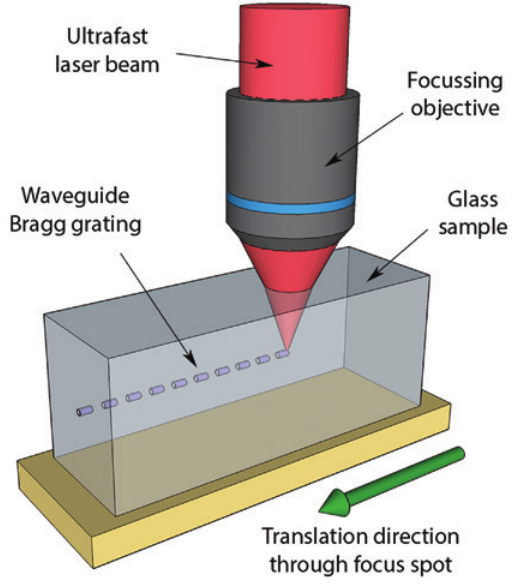
Figure 1: Schematic outlining